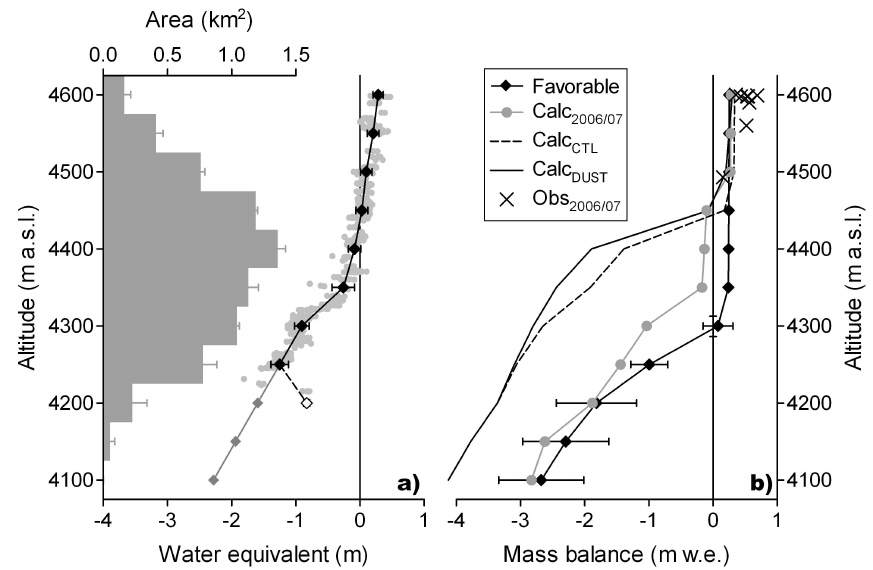
Fig. 4. (a) Altitudinal distributions of area and changes in surface elevation for the Gregoriev Glacier between July 2006 and August 2007. (b) Mass balance profiles calculated for the period 2005–2007 and favorable profile for the present-day glacier geometry. The area data with error bars in (a) are obtained from SRTM and ASTER-GDEM, with the glacier extent delineated from Landsat ETM+ images taken in 1999 and 2006. Grey dots, and black and grey diamonds along the solid line in (a) denote changes in a 1-m grid cell, averages at the 50-m altitude band, and extrapolated changes for the unmeasured lower part of the glacier, respectively. The lowest survey point (open diamond) was excluded from the analysis because it probably detected the bedrock. Black diamonds with error bars, grey circles, and solid and broken lines in (b) denote the favorable mass balance profile for a zero specific mass balance, profile for the period 2006–2007, and profiles for the period 2005–2006, for which the albedo reduction is considered (solid line) or not considered (broken line), respectively. Crosses in (b) denote the mass balance calculated from changes in stake height and from the average snow density.